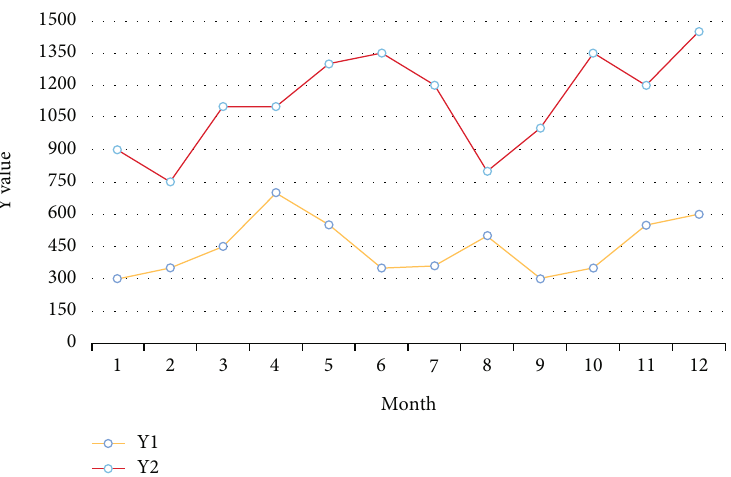
Figure 4: Change trend diagram of evaluation index Y .